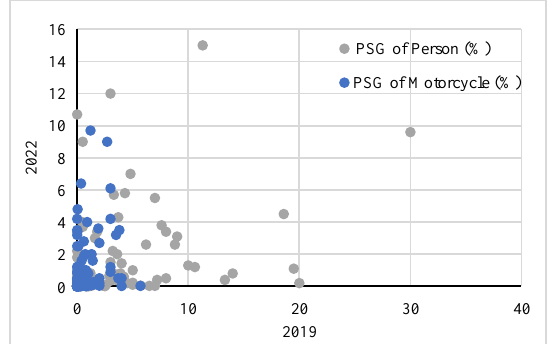
Figure 9. PSG of person and motorcycle.